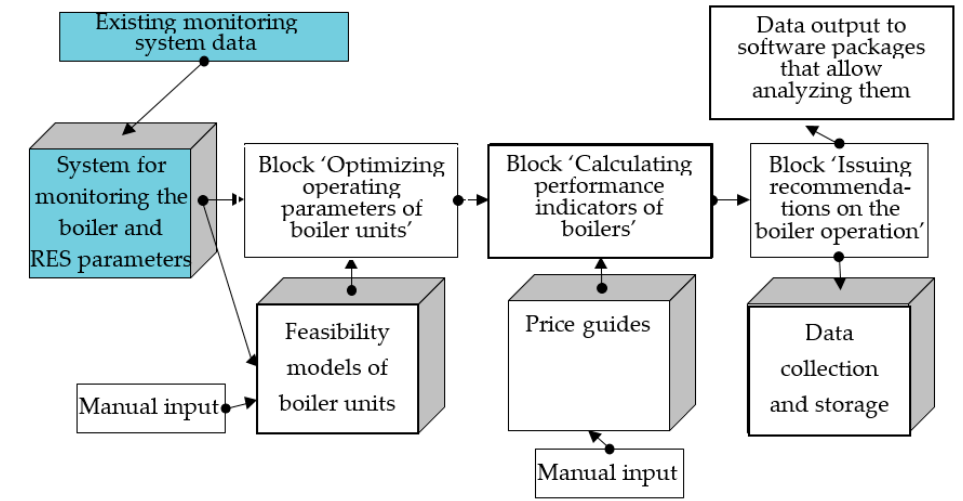
Figure 4. Explanatory Diagram. CAE for Optimizing the Operating Modes of Industrial Power Plants Boiler Units.